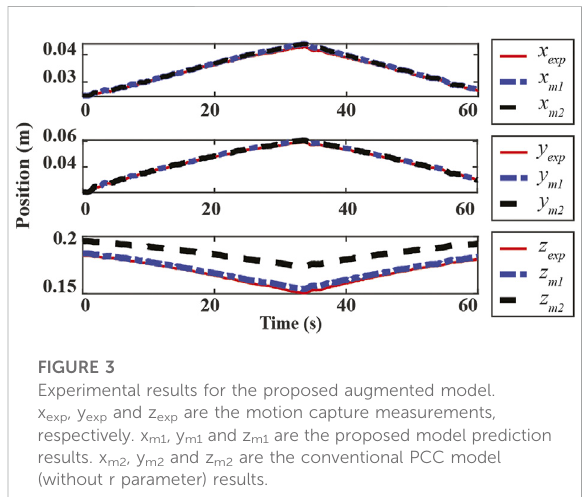
FIGURE 3 Experimental results for the proposed augmented model. x exp , y exp and z exp are the motion capture measurements, respectively. x m1 , y m1 and z m1 are the proposed model prediction results. x m2 , y m2 and z m2 are the conventional PCC model (without r parameter)